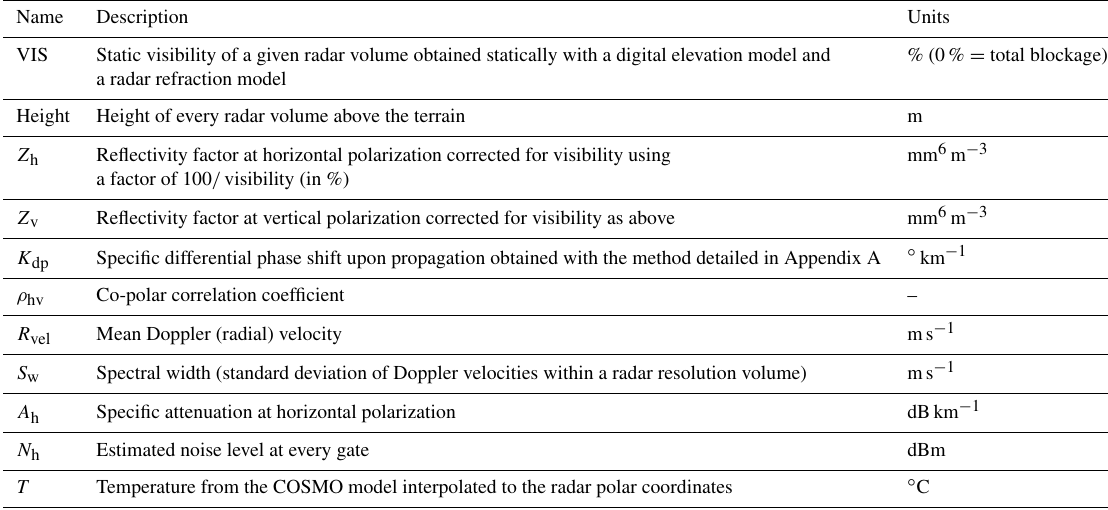
Table 2. List of radar and COSMO variables used aloft the synoptic